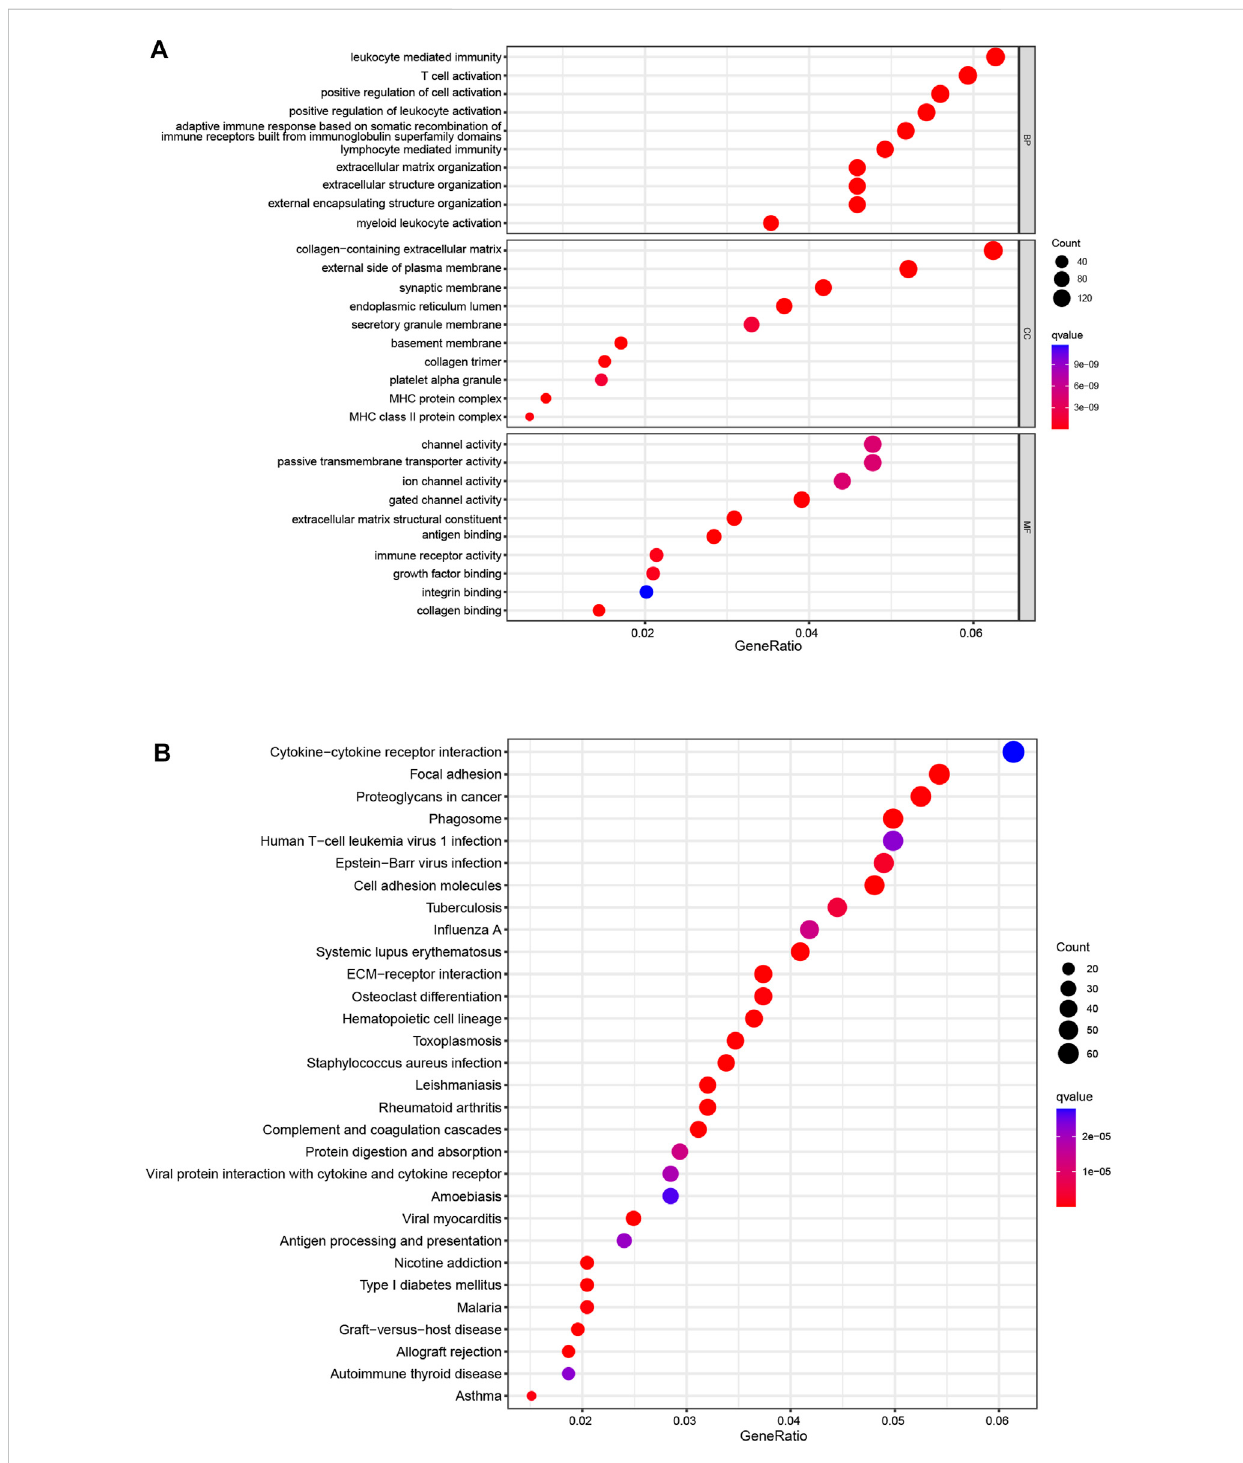
FIGURE 5 Enrichment analyses (A) . GO functional enrichment analysis with bubble plot (BP, biological process; CC, cellular component; MF, molecular function) (B) . KEGG pathway enrichment analysis with bubble plot. GO, Gene Ontology; KEGG, Kyoto Encyclopedia of Genes and Genomes.